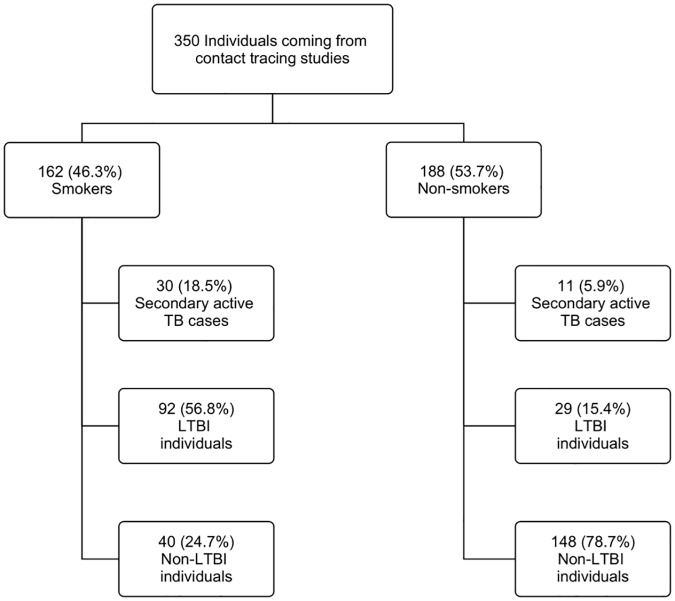
Final diagnosis of all the individuals recruited during contact tracing studies.LTBI, non-LTBI and secondary active TB cases were stratified regarding their smoking or non-smoking condition. LTBI was defined as having positive IGRAs (T-SPOT.TB and/or QFN-G-IT) and a chest radiography without alterations. Active TB cases presented microbiologic confirmation by culture, a compatible radiography with the disease and good clinical response to anti-TB chemotherapy.